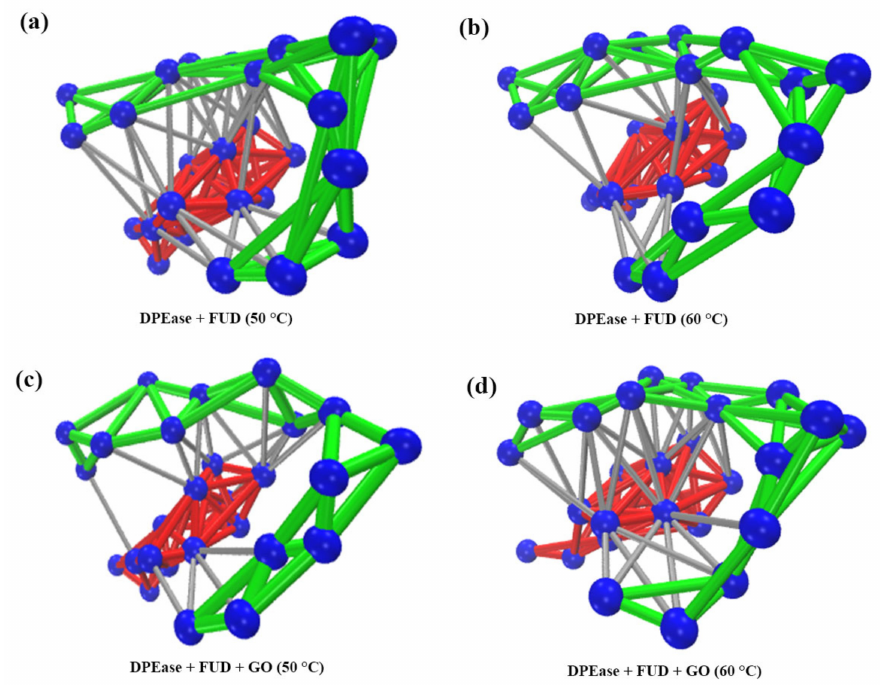
Figure 10. Dynamical network analysis of the interaction between loop β 4- α 4 and loop β 5- α 5 in ( a ) DPEase + FUD (50 ◦ C); ( b ) DPEase + FUD (60 ◦ C); ( c ) DPEase + FUD + GO (50 ◦ C); ( d ) DPEase + FUD + GO (60 ◦ C). The nodes (blue) are α C atoms, the red and green edges repre- sent the interactions between α C atoms of the residues for loop β 4- α 4, loop β 5- α 5, respectively, and the silver edges show the interactions between α C atoms of two